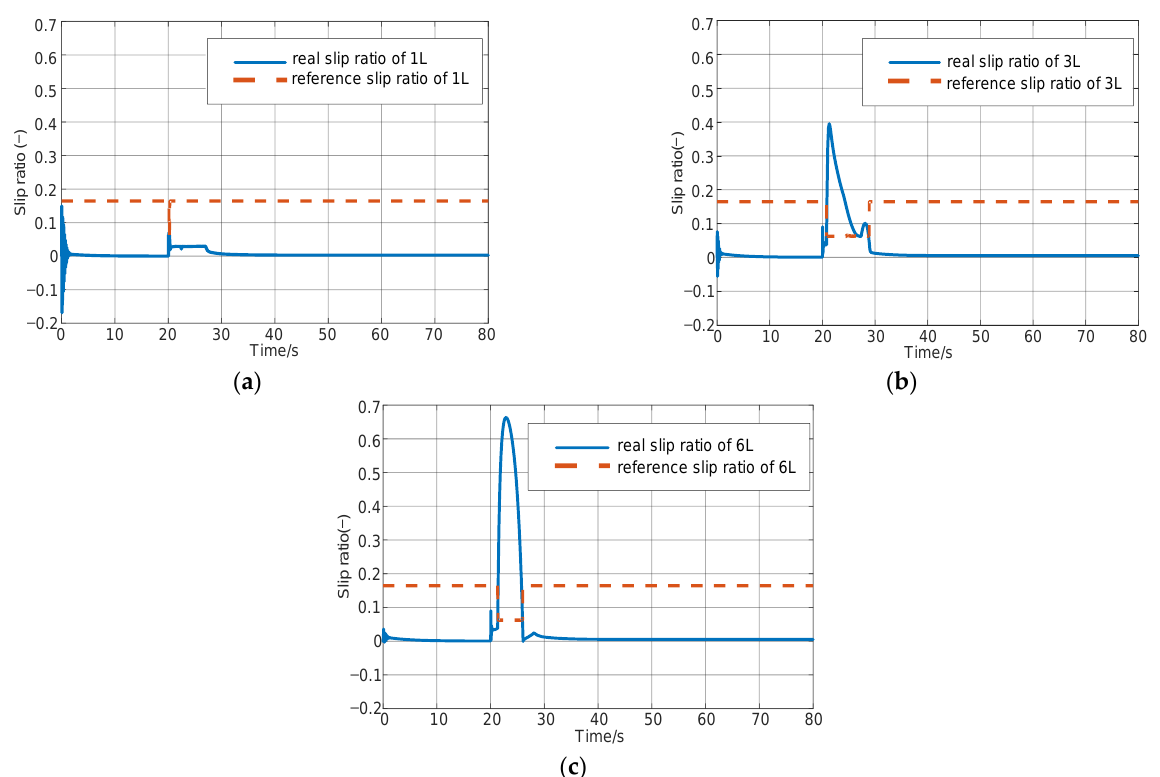
Figure 7. Slip ratio controlled by the PID method on the changed road surface: ( a ) left wheel of the 1st axle (1L); ( b ) left wheel of the 3rd axle (3L); ( c ) left wheel of the 6th axle (6L).